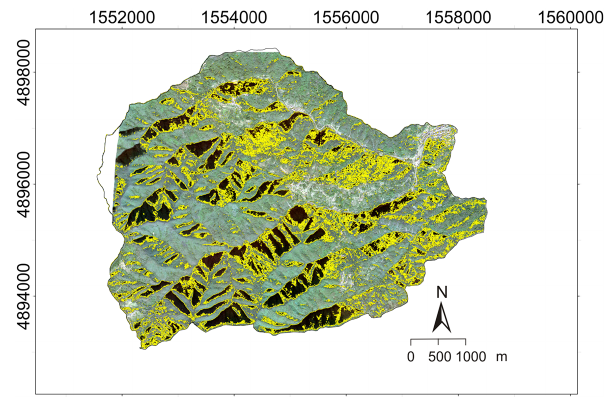
Figure 5. WorldView-2 satellite image. Yellow polygons show the areas considered as shadowed (32% of total).